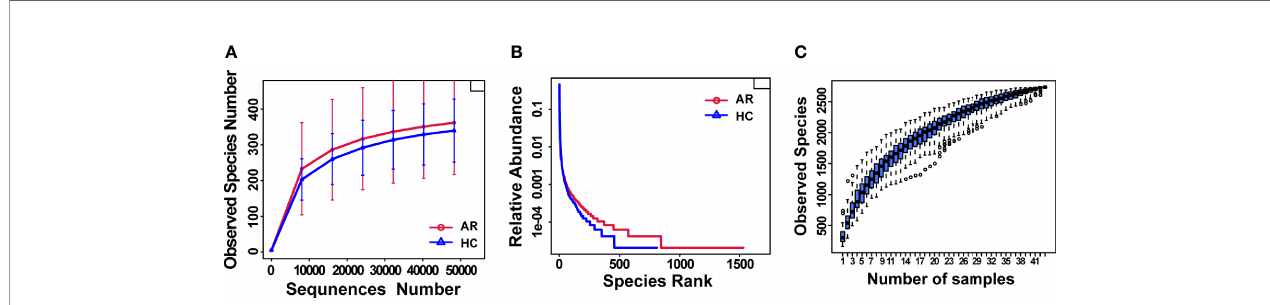
FIGURE 1 | Estimation of sample depth in the AR and HC groups. (A) Rarefaction curves. (B) Rank Abundance curves. (C) Species Accumulation Boxplots. AR, allergic rhinitis; HC, healthy control.